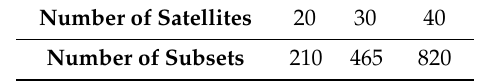
Table 1. Number of subsets of current advanced receiver autonomous integrity monitoring